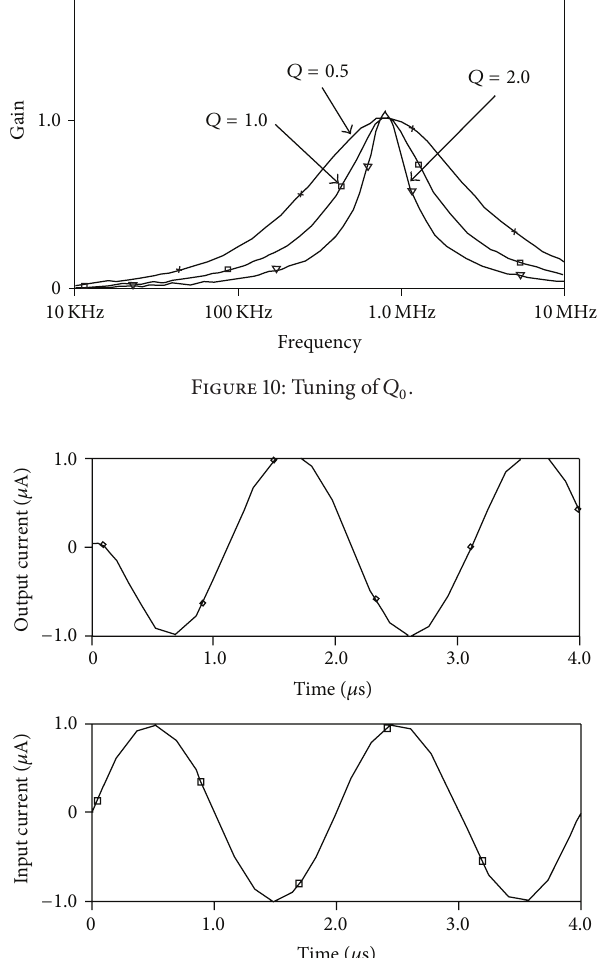
Figure 11: Transient response for low pass